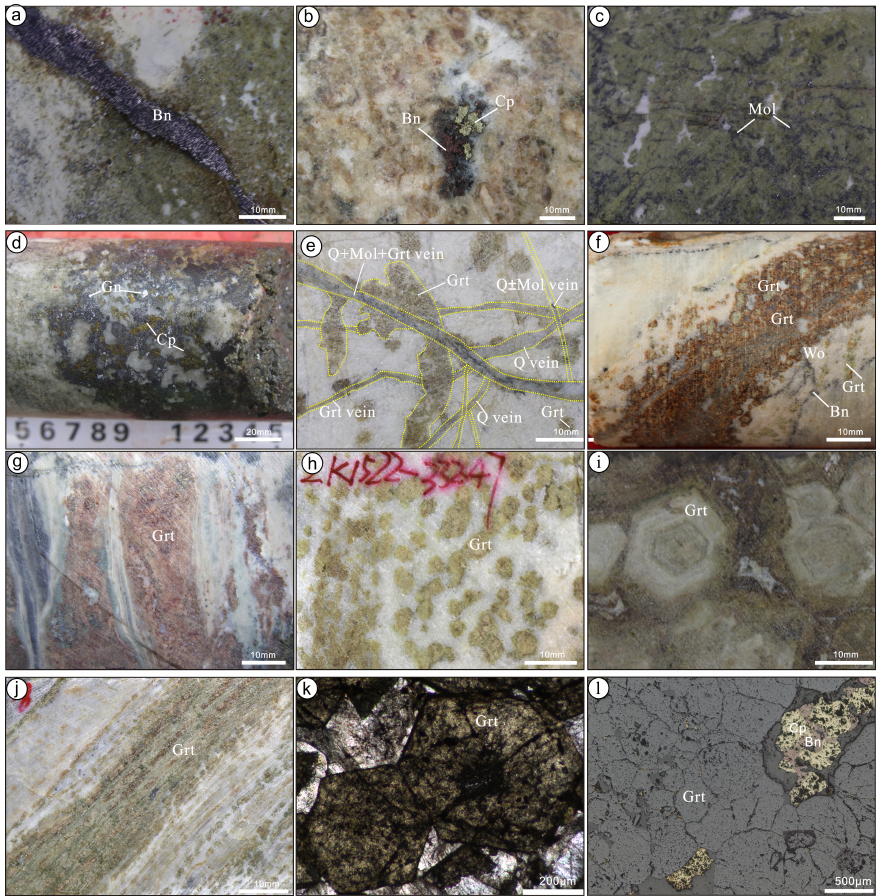
Figure 4. Hand-specimen photos and thin-section microphotographs from the 1# skarn orebody in Jiama Cu–polymetallic system. ( a ): vein Bn in the garnet-wollastonite skarns; ( b ): massive Bn + Cp in the garnet skarns; ( c ): disseminated Mol in the garnet skarns; ( d ) massive Gn + Cp in the skarnized marble; ( e ) the early garnet veins are cut by the later garnet veins and then by the late Q + Mol + Grt veins in the garnet skarns; ( f ) vein Grt + Wo + Bn in the skarnized marble, and ring-shaped garnets can be seen, in which the outer garnet is reddish brown and the inner band is green; ( g ) the red brown garnet veins are produced in the skarn hornstone, which is the result of selective metasomatism; ( h ) the light khaki garnet in the skarnized marble is produced in a massive form; ( i ) hexagonal garnet ring structure;( j ) layered garnet; ( k ) self-shaped granular garnet; ( l ) Cp + Bn is filled between pomegranate seeds. Q = quartz, Cpy = chalcopyrite, Mol = mo- lybdenite, Gn = galena, Bn = Bornite, Cp = Chalcopyrite Grt = garnet, Wo = Wollastonite.